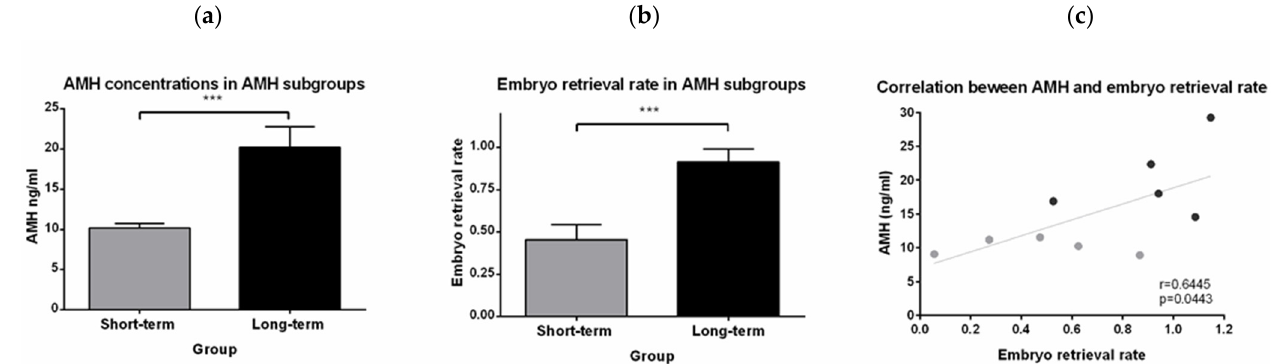
Figure 4. Determination of serum anti-Müllerian hormone (AMH) concentrations (in ng/mL) and correlation with ERR in subgroups. ( a ) Presentation of the AMH concentrations in ng/mL (*** p < 0.001) and ( b ) of the ERR (*** p < 0.001) in the STG ( n = 5) and LTG ( n = 5), respectively. ( c ) The ERR is positively correlated ( p = 0.0443) with AMH concentrations. Animals in the STG (grey dots) cluster with low ERRs and low AMH concentrations and vice versa for animals in the LTG (black dots).